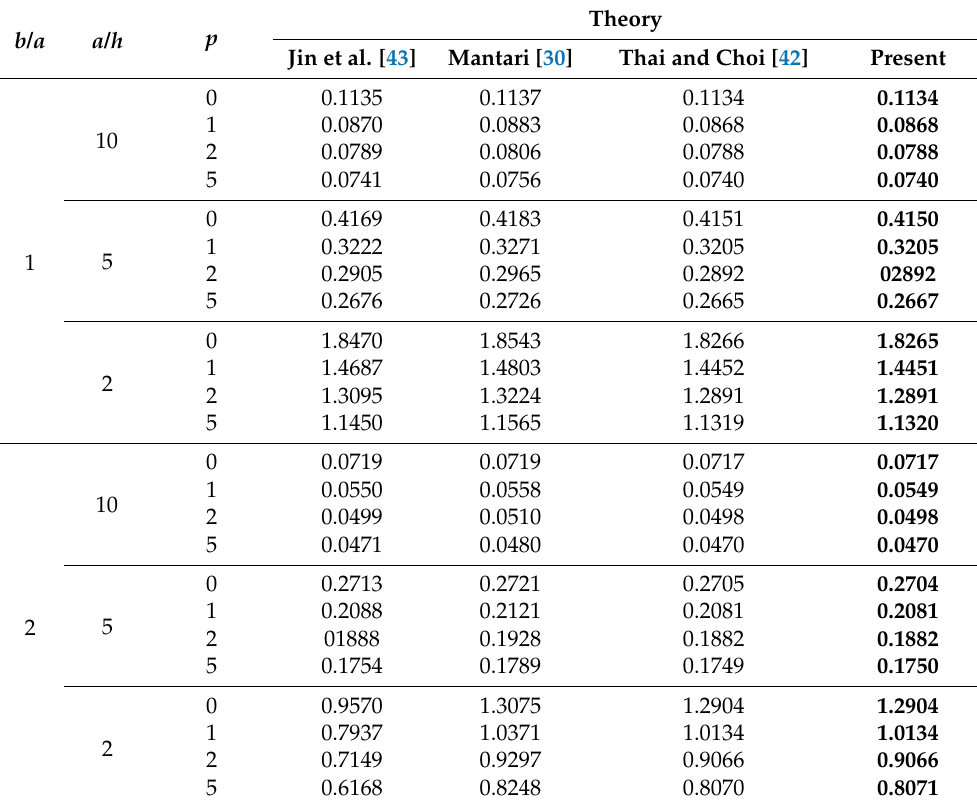
Table 3. Comparison of non-dimensional fundamental frequency ( ω = ω h ported square functionally graded plate ( Al / Al 2 O 3 )